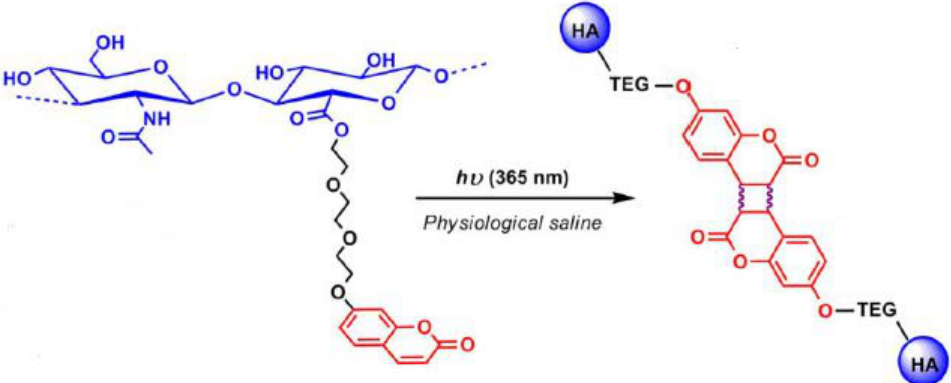
Figure 46. Photocross-linking of hyaluronic acid (HA)-triethylene glycol (TEG) coumarin. Reprinted from [236], Copyright (2019), with permission from Elsevier.